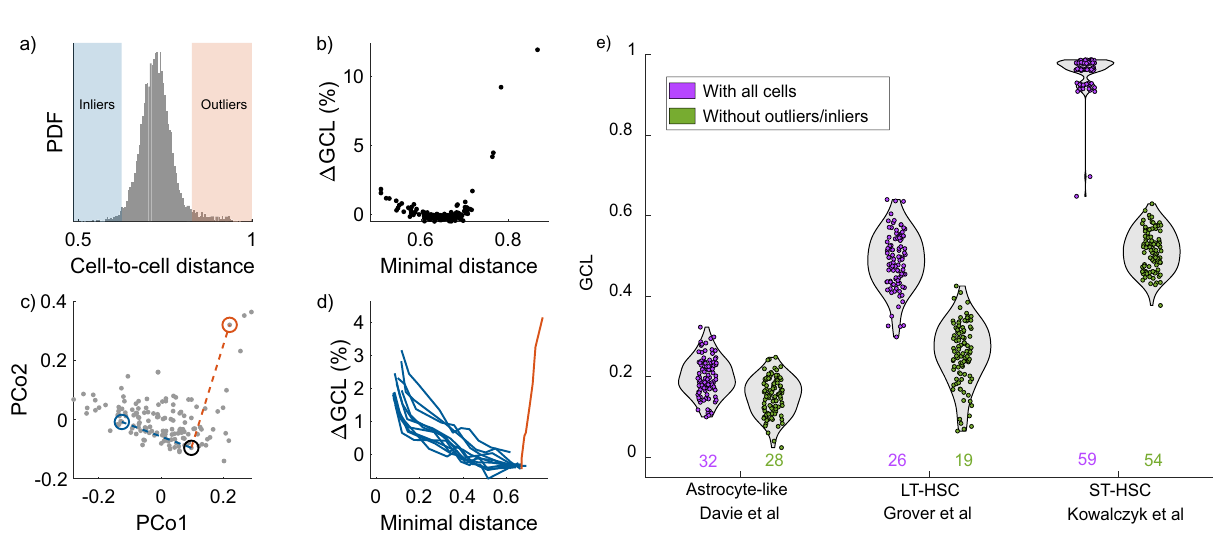
Figure 1. The effects of outliers and very similar cells (‘inliers’) on the GCL. The GCL value of ST-HSCs from young mice 19 is analyzed with respect to the effects of individual outlier and inlier cells. ( a ) Proposed procedure of characterizing inliers and outliers. The histogram represents the distribution of cell-to-cell ‘distance’, measured as the Spearman dissimilarity, among all the cells. The blue and red shaded areas represent distance values smaller or larger than two standard deviations from the mean, respectively. ( b ) The effect on the GCL of each cell is measured with respect to its minimal distance to any other cell. The effect on the GCL is measured by the difference between the GCL values calculated with and without the cell (Eq. 13). Cells with unusually high or low minimal distance (outliers or inliers) have the most effect on the change in the GCL. ( c ) PCA plot of the cells. The dashed lines represent the trajectories simulated cells undergo as they transform from an average cell to an inlier cell (blue line), or to an outlier (red line). ( d ) Examples of introducing a simulated inlier or outlier cell into the real data. Each blue line represents the effect of a simulated cell which is a linear combination between an inlier and an average cell (10 simulations in total). As the distance between it and another cell decreases, its effect on the GCL increases. The red line represents a similar procedure for the outlier case. ( e ) GCL values of three different datasets from Refs. 19,21,22 (see “Material and methods” section). Each dot represents an individual jackknife procedure, and the grey violin plots represent the distribution of values. For the ST-HSC case, the cells are from old mice. The number of cells before and after filtering is written below, with the corresponding colors. The presence of outliers/inliers tends to increase the GCL value, with a bimodel distribution apparent in the ST-HSC case where the effects of the outliers are especially pronounced. The GCL value before and after removal of the outliers/inliers was changed by the following values 23% , 46% , 47% (corresponding to the ordering of the figure). We removed obvious clusters from the Astrocyte-like and LT-HSC clusters (see The effect of clusters section). The number of jackknife realizations in each case is 100, with each realization containing 70% of the cells in the cohort. In all cases, the number of random divisions, m , is equal to 2000 expressed genes are 50, and the top N =